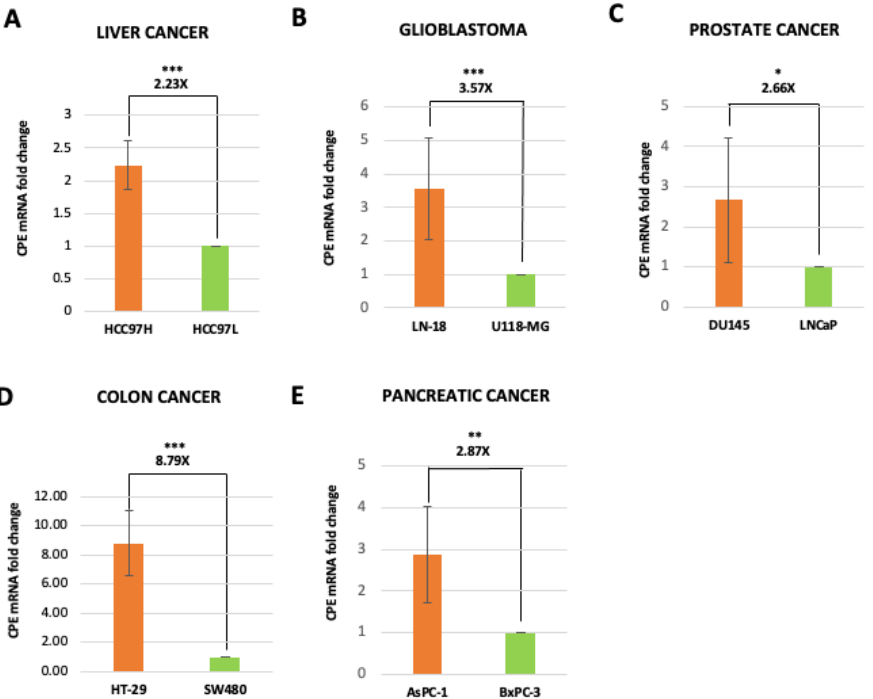
Figure 2. Malignant cancer cells release exosomes with elevated CPE copy numbers. ( A – E ) Bar graph showing the fold change of CPE mRNA copy numbers measured in exosomes derived from malignant/aggressive cells (orange bars) versus low-malignant cells (green bars) from different types of cancer as denoted in the figure (N = 3 for ( B , C , E ) and N = 2 for ( A , D )). Standard curve method using CPE 5 ′ -DNA fragment of known concentration was used to perform quantitation of CPE mRNA copy numbers. Data represents mean ± SD of 2 or 3 independent experiments. Error bars denote SD. Statistical analysis for all panels was performed by Student’s t -test: *, p < 0.05; **, p < 0.01; ***, p < 0.001.